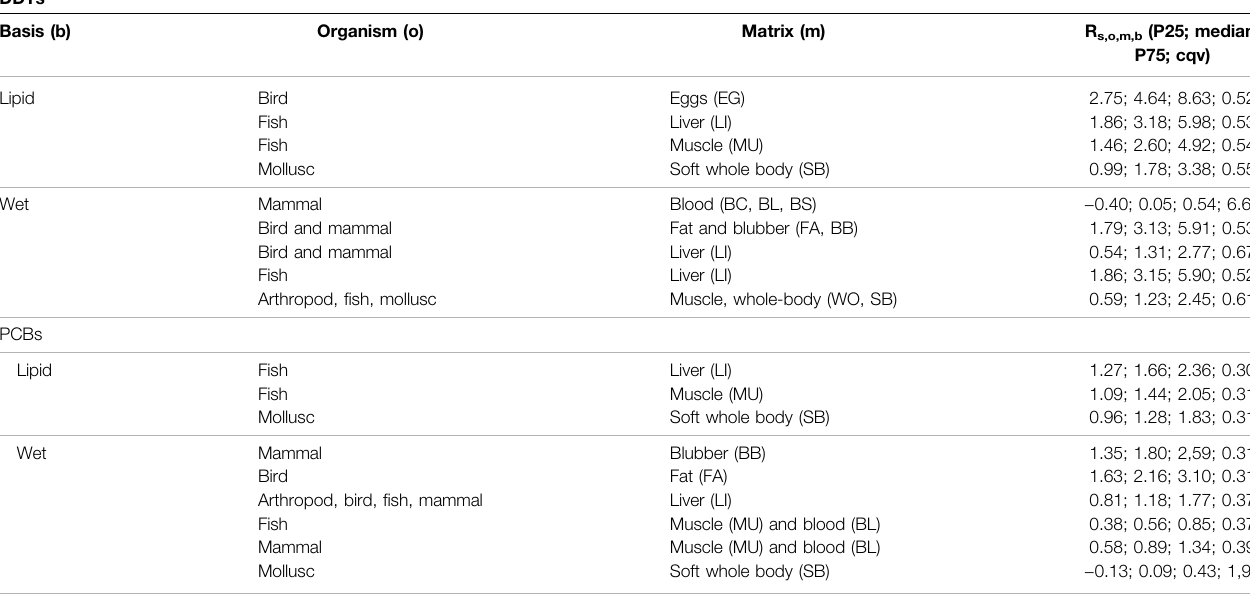
TABLE 4 | Organism-to-pellet DDTs and PCBs ratios, R DDT,o,m,b . and R PCB,o,m,b .